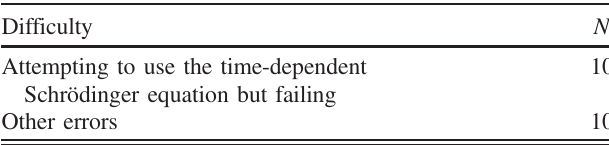
TABLE I. Difficulties in step C1: setting up a basic equation for the energy eigenfunction problem. Note that there may be multiple errors in one student ’ s answer, thus the sum of N in the table need not be equal to the number of student solutions. This case is applicable to the following tables.